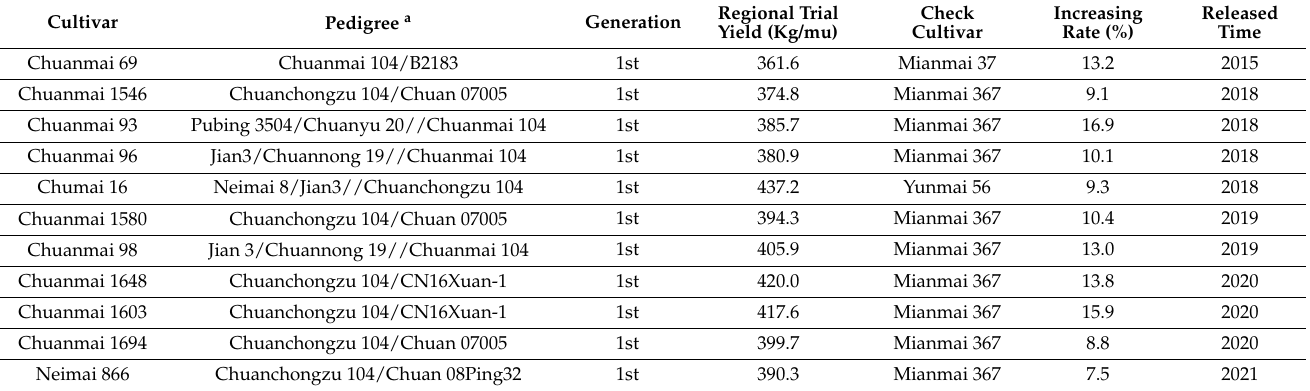
Table 4. Cultivars released from the cross involving Chuanmai 42 in southwestern China.